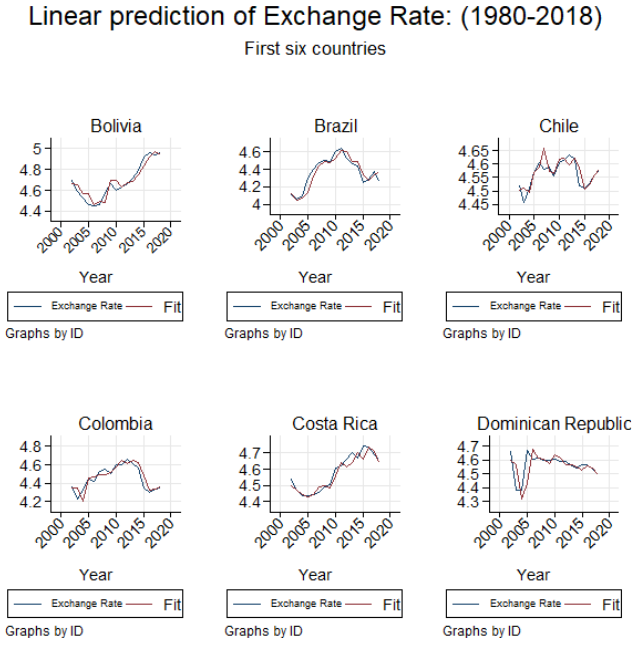
Figure1: Linear Prediction of Exchange Rate